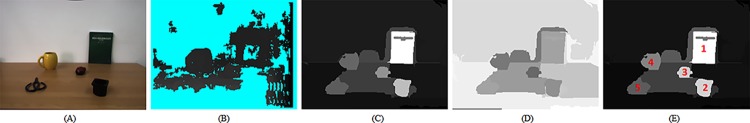
An instance running on the robot platform.A: left camera image captured by the Triclops stereo vision SDK of the Bumblubee-2 stereo camera. B: raw disparity map, computed automatically by the Bumblubee-2, in which the aqua color parts show the areas where the disparities are not available. C: primary saliency map. D: background distribution map. E: final saliency map with manual annotation for the attention shift sequence.